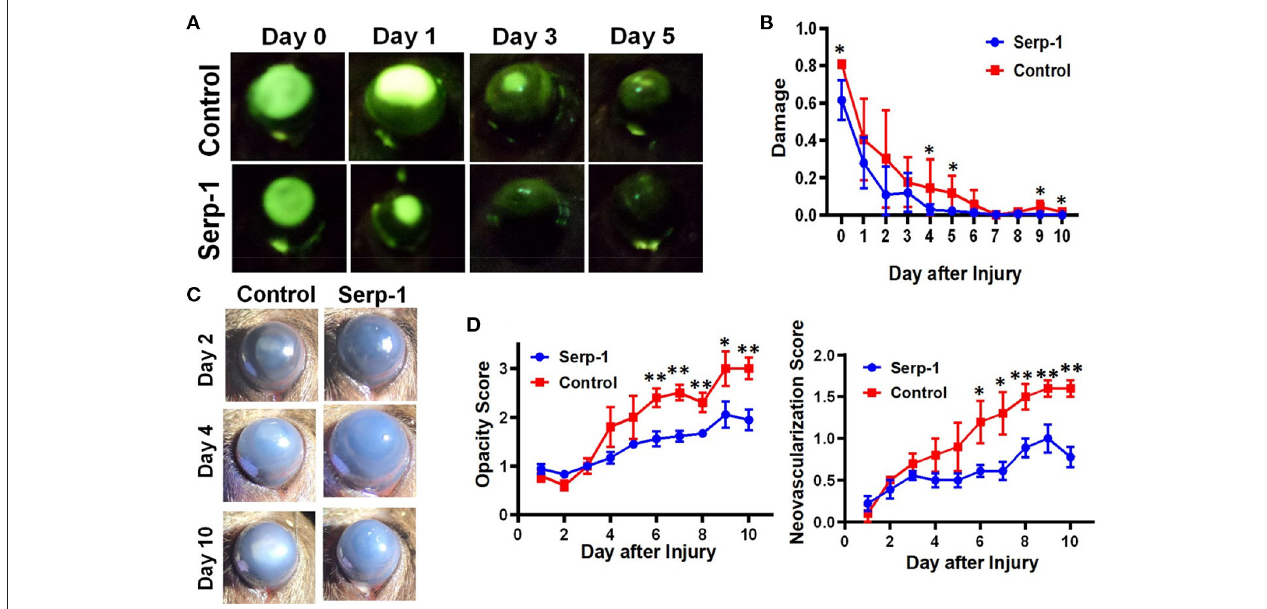
FIGURE 1 | Serp-1 contributes to the corneal wound healing process by limiting the inflammatory response. (A) Treatment with Serp-1 shows improved re-epithelialization in mouse corneas with an alkaline induced injury ( n = 5 for control group and n = 9 for Serp-1 group). (B) Quantification of fluorescent signal in (A) by dividing the fluorescein positive area by total corneal area (data were presented as mean ± S.D. * P < 0.05). (C) Bright-field imaging shows reduced fibrosis and encroachment of the cornea by neovascularization in mice treated with Serp-1. (D) Quantification of corneal fibrosis and neovascularization using a modified Hackett-McDonald scoring system (data were presented as mean ± S.D. * P < 0.05; ** P < 0.01).